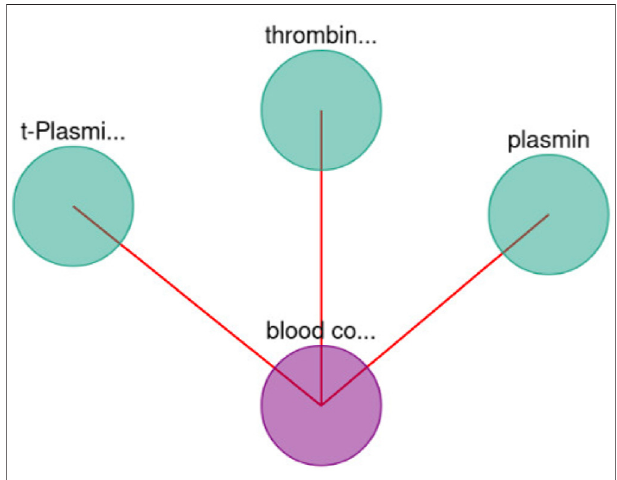
FIGURE 9 | Blood coagulation and enzymes